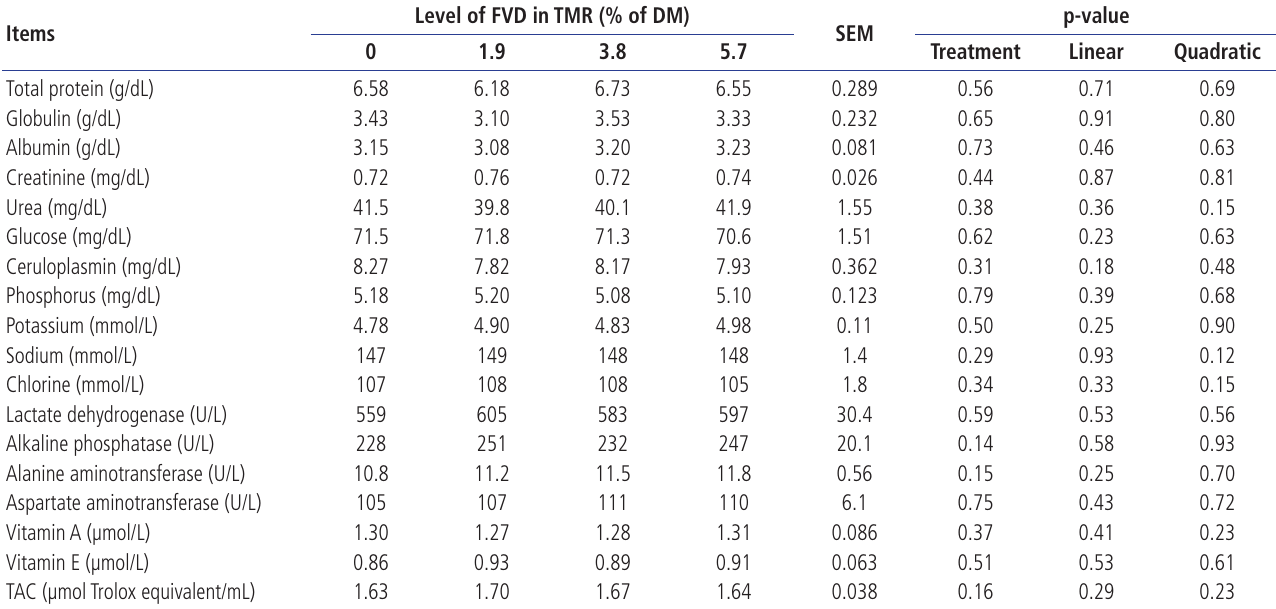
FVD, fruit and vegetable discards, mixed with 6 g sodium metabisulfite/kg wet FVD and aerobically challenged for 7 d; TMR, total mixed ration; DM, dry matter; SEM, standard error of the mean; TAC, total antioxidant